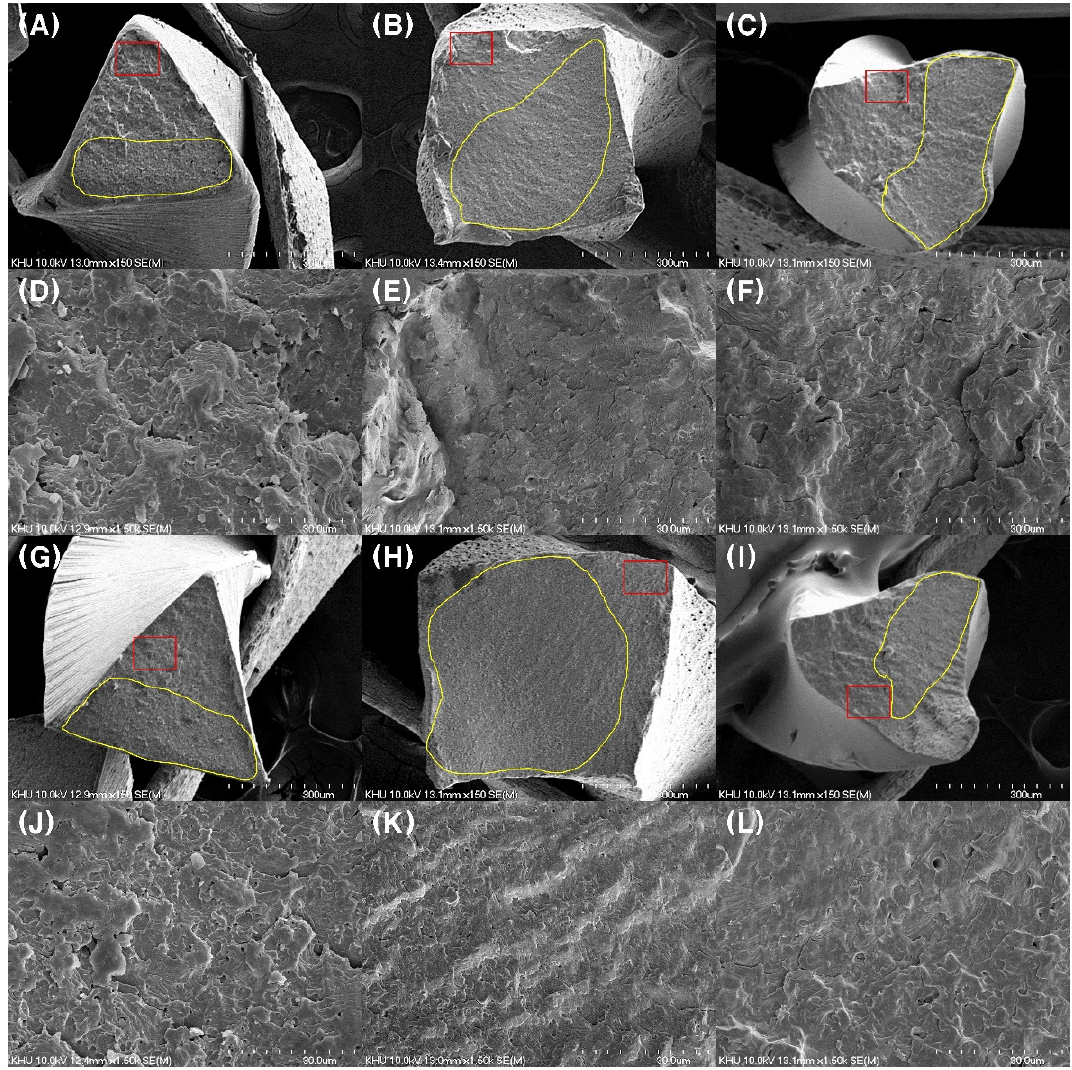
Figure 2. SEM images of fractured surface after cyclic fatigue resistance test. ( A – C ) Fractured surface of HyFlex CM, HyFlex EDM, and OneFlare after test performed at RT, ductile fracture area was marked with yellow boundary; ( D – F ) magnified images of box area of ( A – C ), respectively; ( G – I ) fractured surface of HyFlex CM, HyFlex EDM, and OneFlare after test performed at BT, ductile fracture area was marked with yellow boundary; ( J – L ) magnified images of box area of ( G – I ),